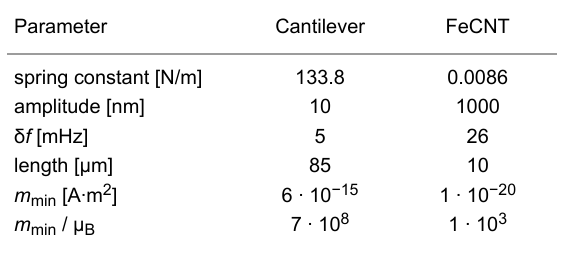
Table 3: Minimal detectable magnetic moment for both subsystems of the coupled system. The calculations have been made for room tem- perature T = 293 K, a bandwidth of B w = 1 Hz and magnetic field of B ext = 1